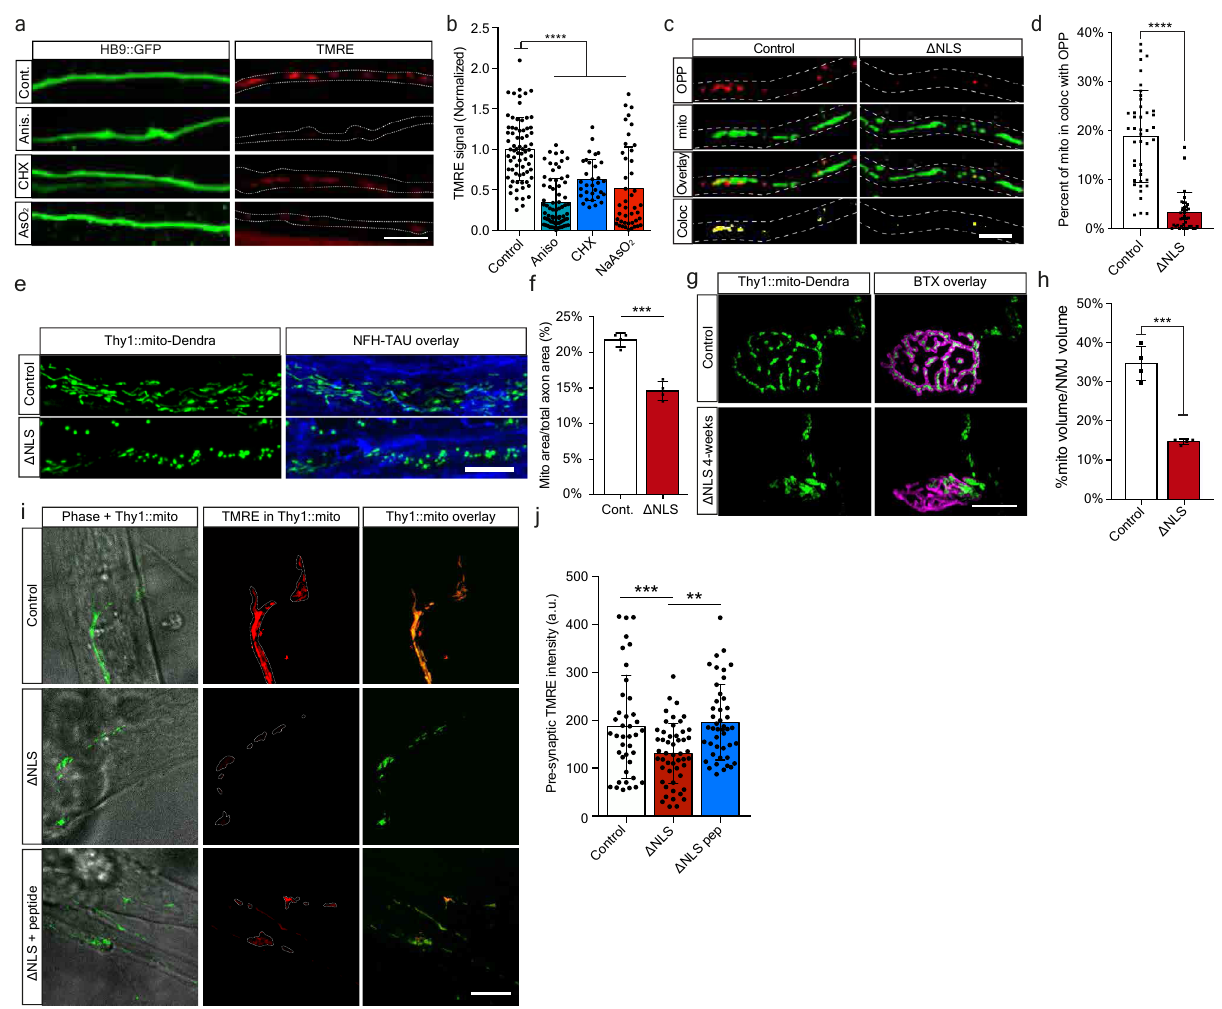
Fig. 5 TDP-43 mislocalization impairs axonal and NMJ mitochondria via limitation of mitochondria-related protein synthesis. a Images and b quanti fi cation of TMRE signal in HB9::GFP MN axons untreated (control) or treated with anisomycin (aniso), cycloheximide (CHX) or NaAsO 2 . Scale bar = 10 µ m. n = 72,69,43,32 axons. Data are presented as mean values ± SD. One-way-ANOVA with Holm-Sidak correction. **** p < 0.0001. c Images and d quanti fi cation of OPP and mitochondria colocalization in TDP Δ NLS or control MN axons. Scale bar = 5 µ m. n = 43,36 axons. Data are presented as mean values ± SD. Unpaired -t -test, two-sided **** p < 0.0001. e images and f quanti fi cation of mitochondria density within sciatic nerve longitudinal sections of TDP Δ NLS Thy1::MitoDendra and control mice labeled also for NFH and Tau. Scale bar = 10 µ m. n = 4,4 mice. Data are presented as mean values ± SEM. Unpaired- t -test, two-sided. *** p = 0.0001. g Images and h quanti fi cation of pre-synaptic mitochondrial volume within NMJs of TDP Δ NLS Thy1::MitoDendra and control Thy1::MitoDendra mice. BTX marks post-synapse. Scale bar = 10 µ m. n = 4,4 mice. Data are presented as mean values ± SEM. Unpaired- t -test, two- sided. *** p = 0.0001. i Images and j quanti fi cation of pre-synaptic TMRE signal intensity within in vitro NMJs from TDP Δ NLS Thy1::MitoDendra , control Thy1::MitoDendra co-cultures and TDP Δ NLS Thy1::MitoDendra co-cultures treated with G3BP1 peptides in NMJ compartment. Scale bar = 10 µ m. n = 40,51,45 NMJs. One-way-ANOVA with Holm-Sidak correction. Data are presented as mean values ± SD. ** p = 0.0034, *** p = 0.0005. a.u stands for arbitrary units. Source data are provided as a Source Data fi